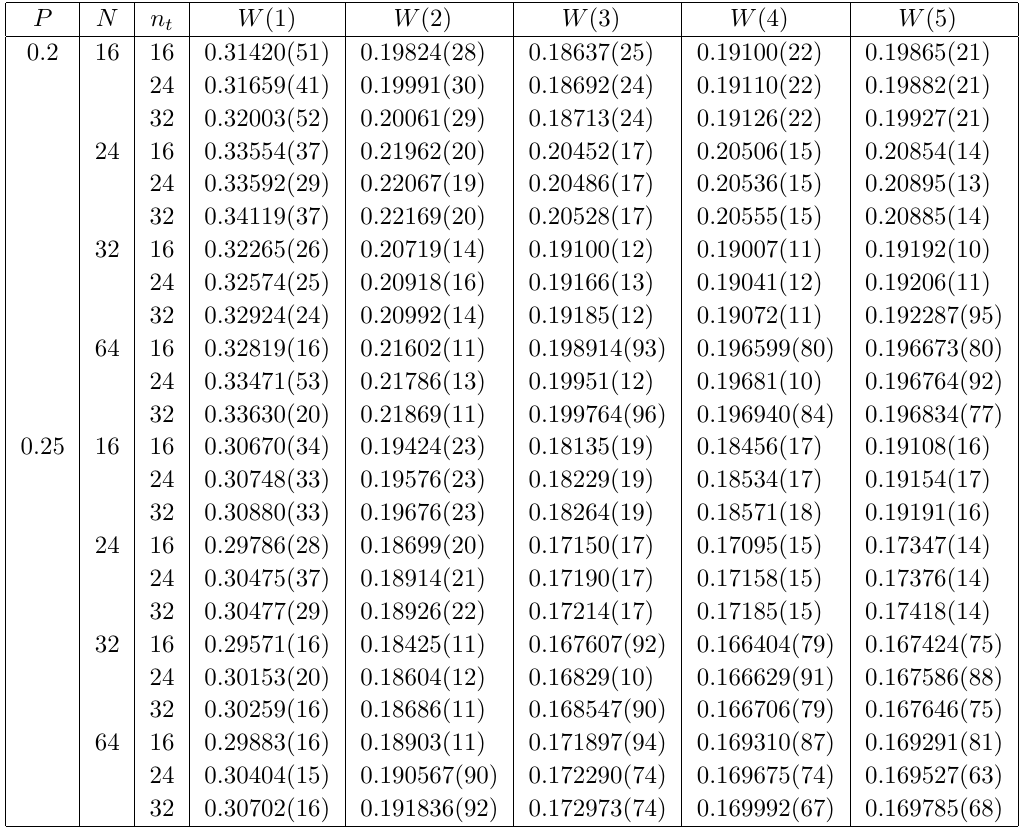
Table 12. W dec for L = 1 , 2 , 3 , 4 , 5 , constrained, T = 0 . 29 . Open